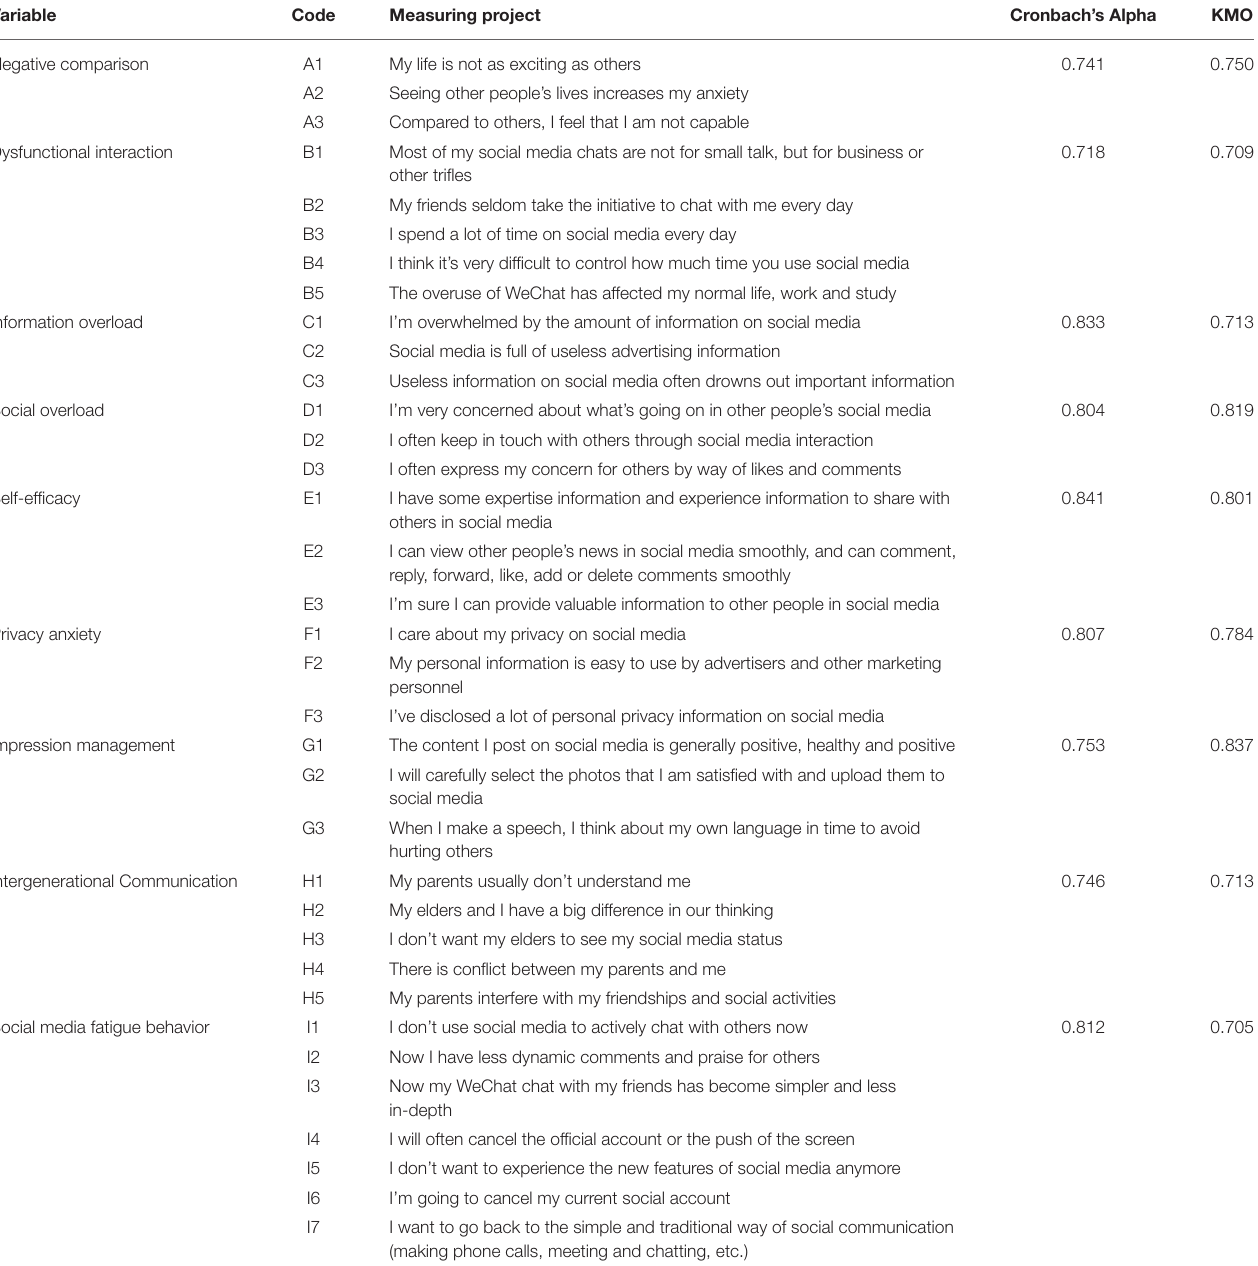
TABLE 2 | Items and reliability and validity of the scale.